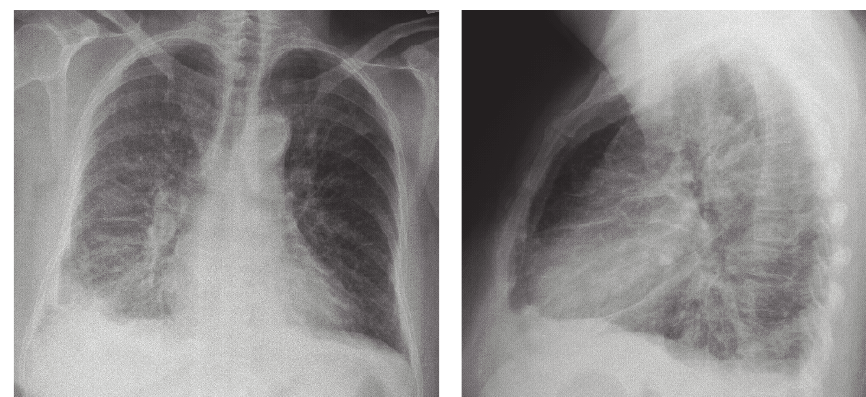
Figure 3: CXR on second admission.